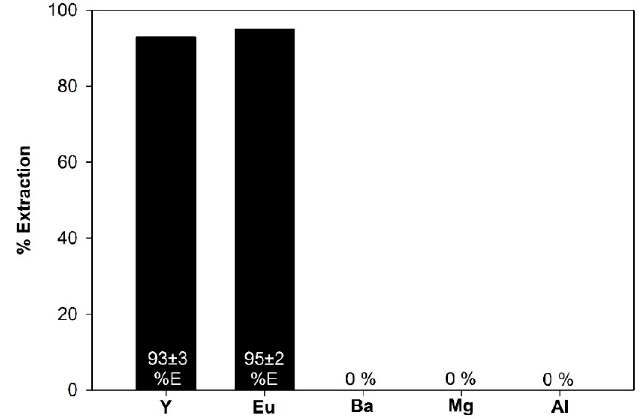
Figure 12. Extraction from phosphor leachate in 8 M HCl with 0.072 M TBDGA in 1 ‐ octanol, 0.5 mol% 1 ‐ octanol, 23 °C, 5 mL/min, 24.1 MPa.